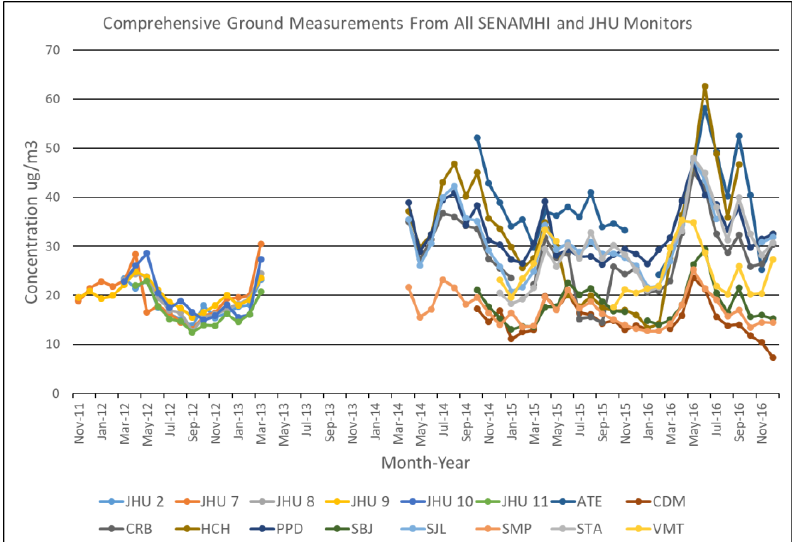
Figure 2. Time series of monthly mean ground PM 2.5 measurements in µg/m 3 at each monitor station for both the SENAMHI and JHU networks from November 2011 through December 2016. SENAMHI station names are abbreviated from the name of the location.